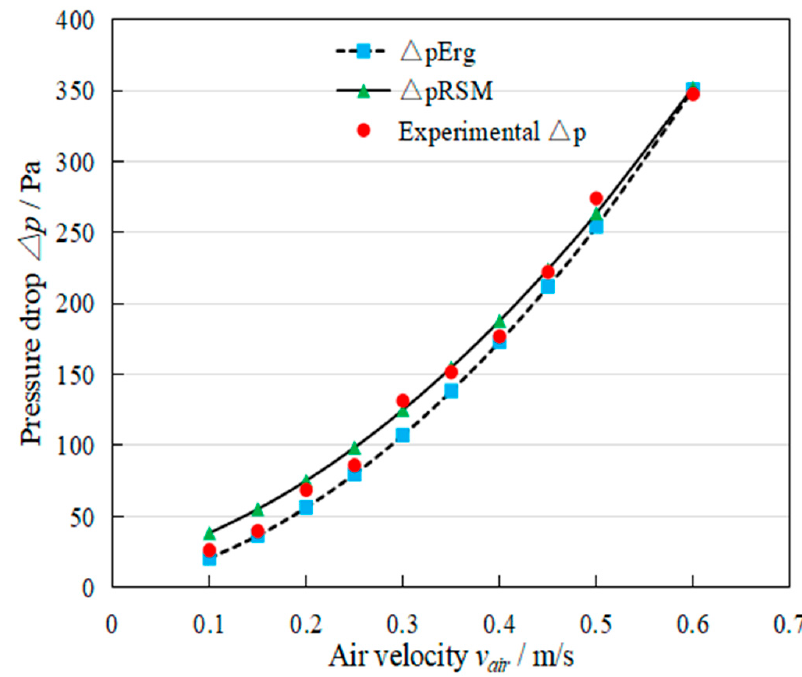
Figure 8. The variations of ∆ p with v air under the constant Mc of 18.9 %w.b. and L of 0.5 m.